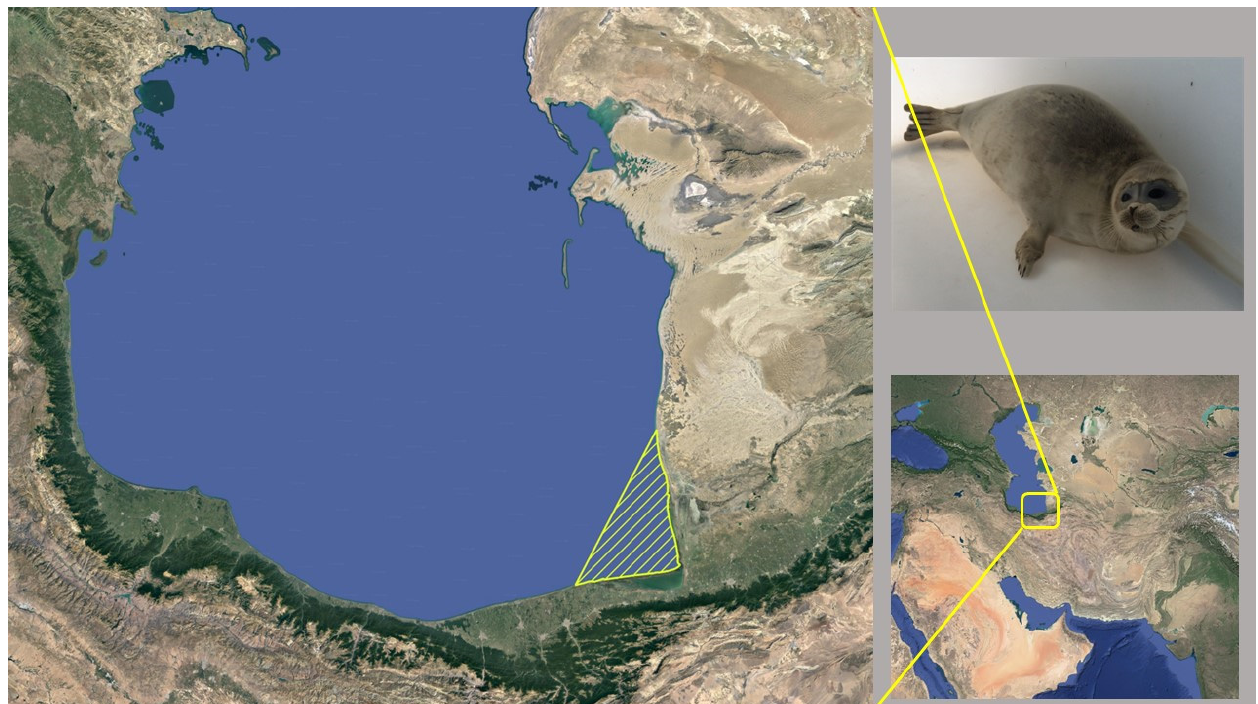
Figure 1. Sampling area (yellow-stripped area on the left) of stranded Caspian seals in Iran (2013–2016).